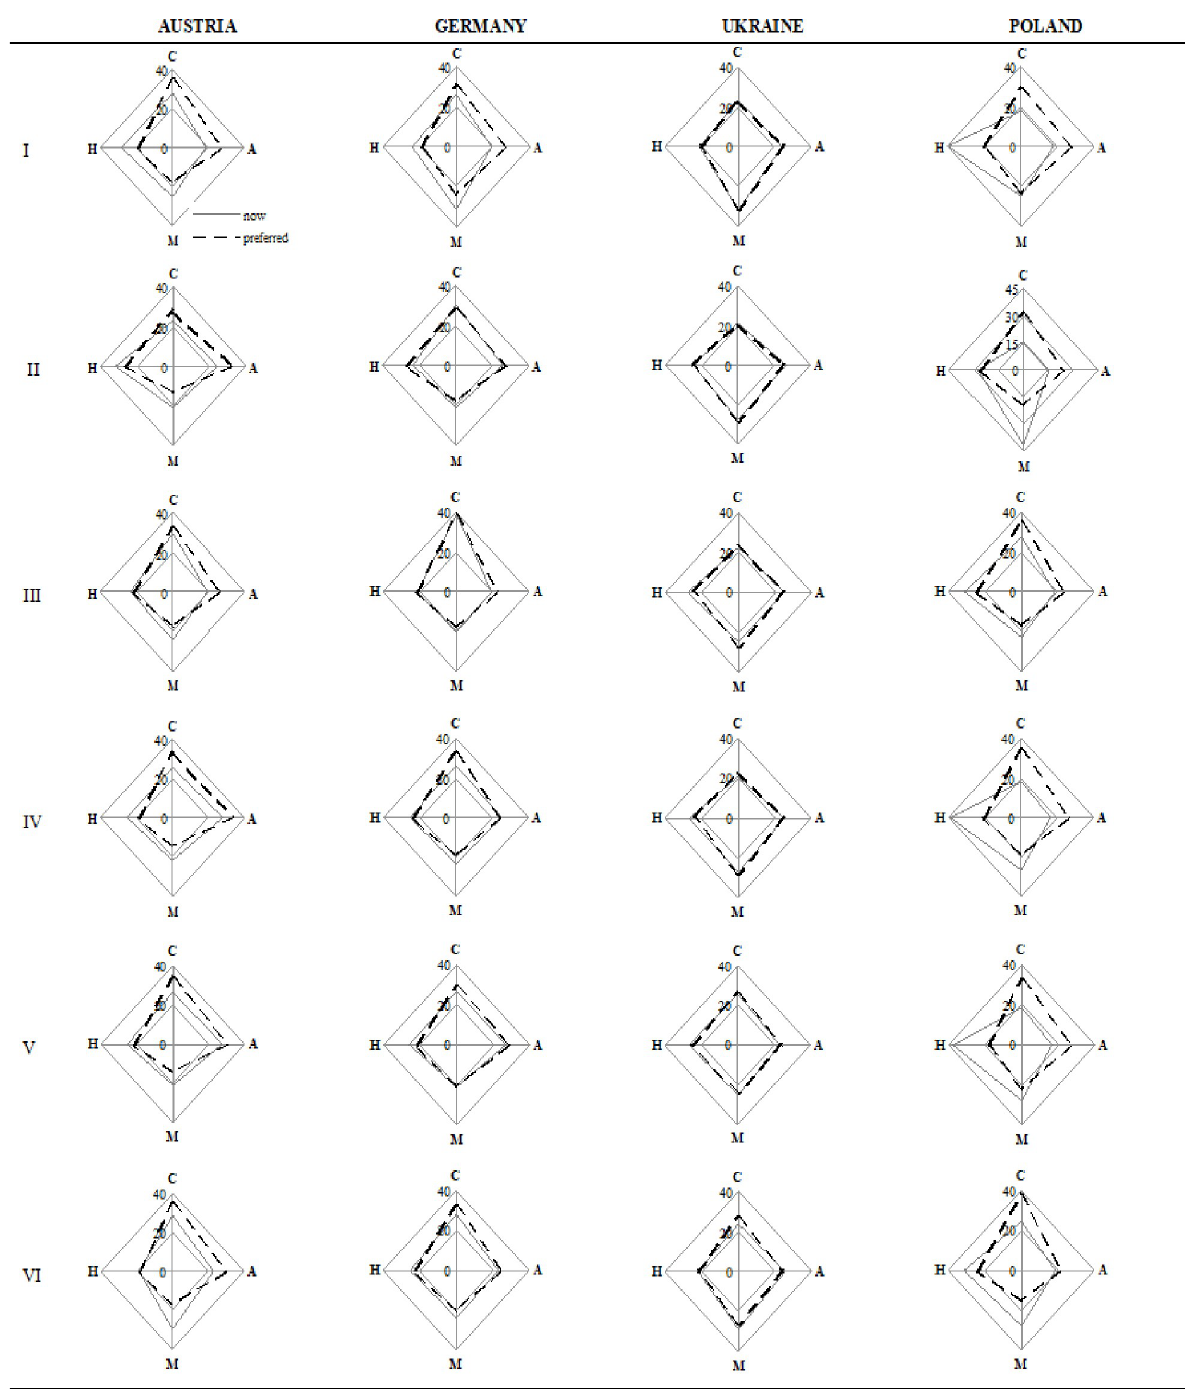
Fig 4. Mean culture profiles for each area in the selected countries. Areas: general characteristics of the organisation (I), leadership style (II), personnel management style (III), organisation integrity (IV), key areas in the organisation (V), success criteria (VI). Profile: Clan (C), Adhocracy (A), Market (M), Hierarchy